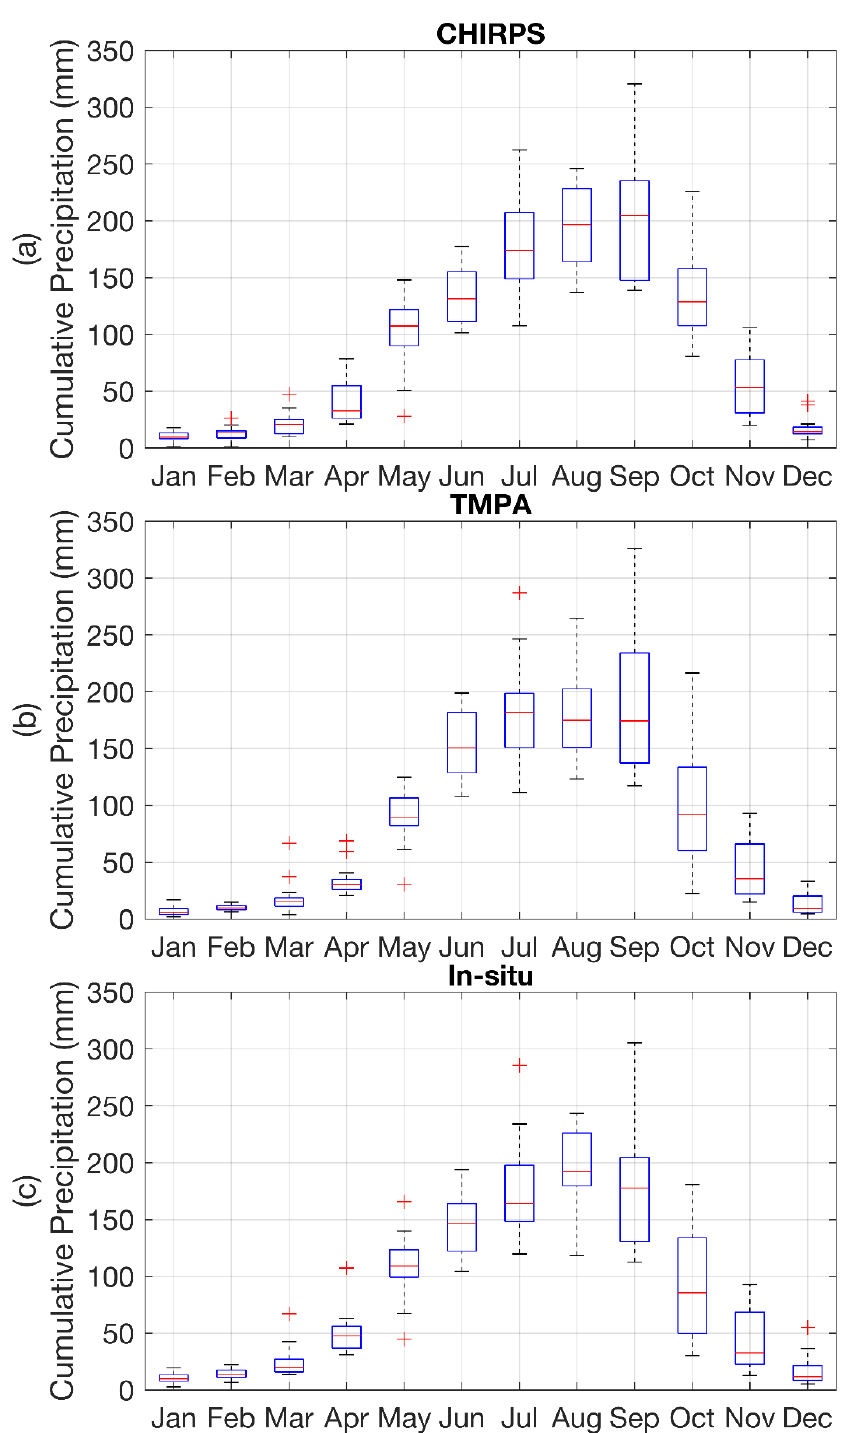
Figure 4. ( a ) Boxplot analysis of each month using rain gauge measurements. ( b ) Boxplot analysis Figure 4. of each month using TMPA estimates. ( c ) Boxplot analysis of each month using CHIRPS estimates. Each analysis uses data from 2000 to 2014. Red horizontal bars represent the median rainfall amount. The blue boxes represent the data that is within the 25th and 75th percentiles. The black horizontal bars above and below the blue boxes represent the maximum and minimum rainfall amounts, respectively. The red ‘ + ’ represent outliers in the data